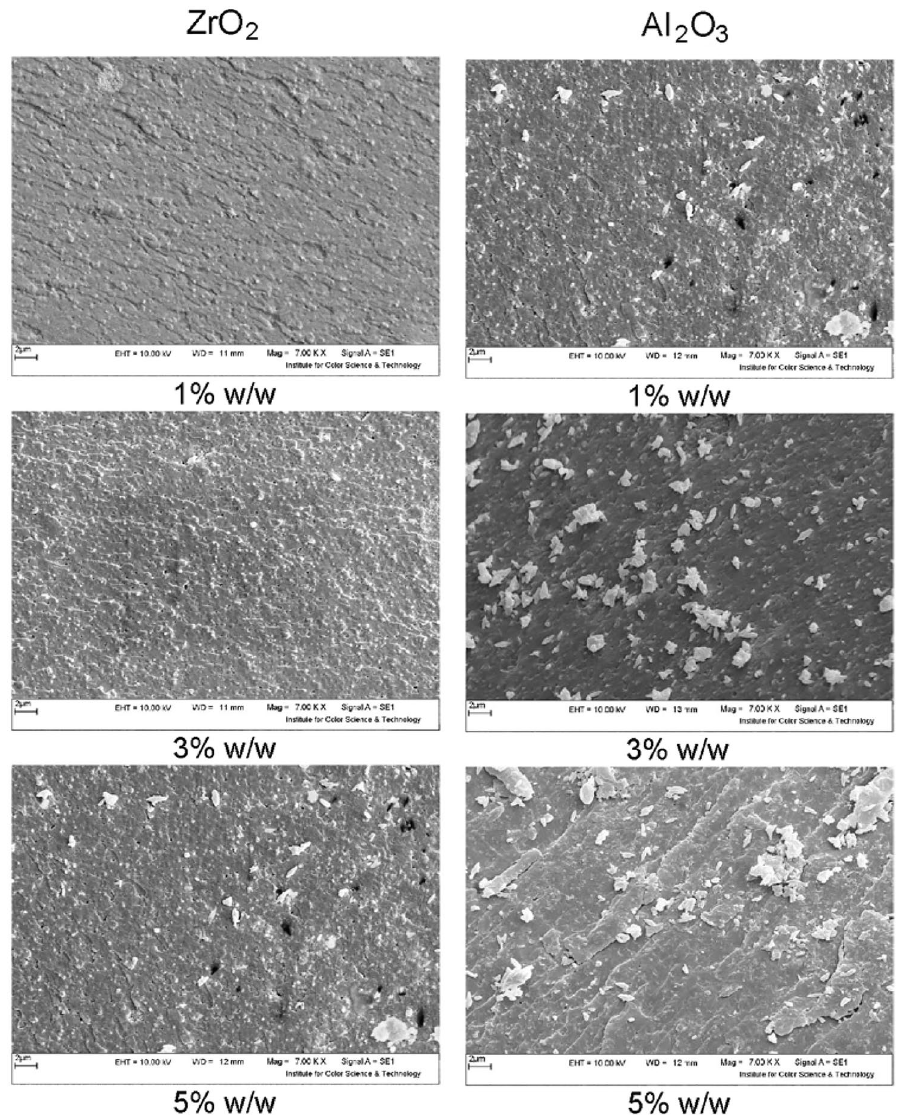
Figure 1. SEM images of polyurethane nanocomposite coatings with different amounts of nano ZrO 2 and Al